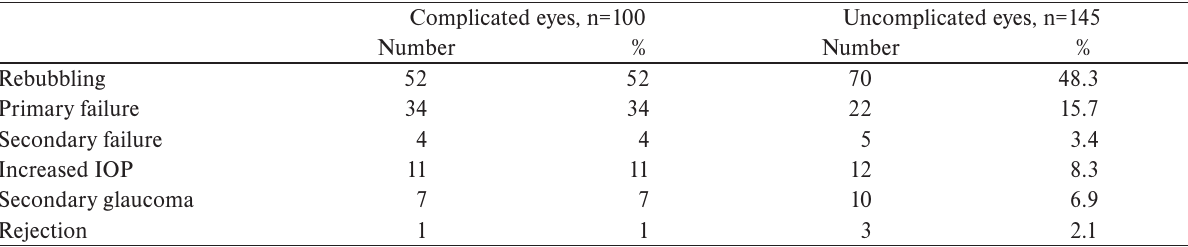
Table 3. Comparing the numbers of individual postoperative complications in Groups 1 and 2. Complicated eyes,